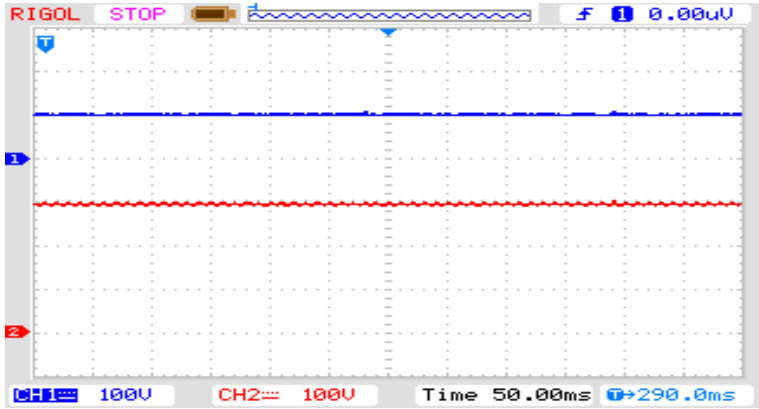
Figure 26. Voltage across the capacitor CH1 and total DC-link voltage of TLBC CH2 for D = 0.5.